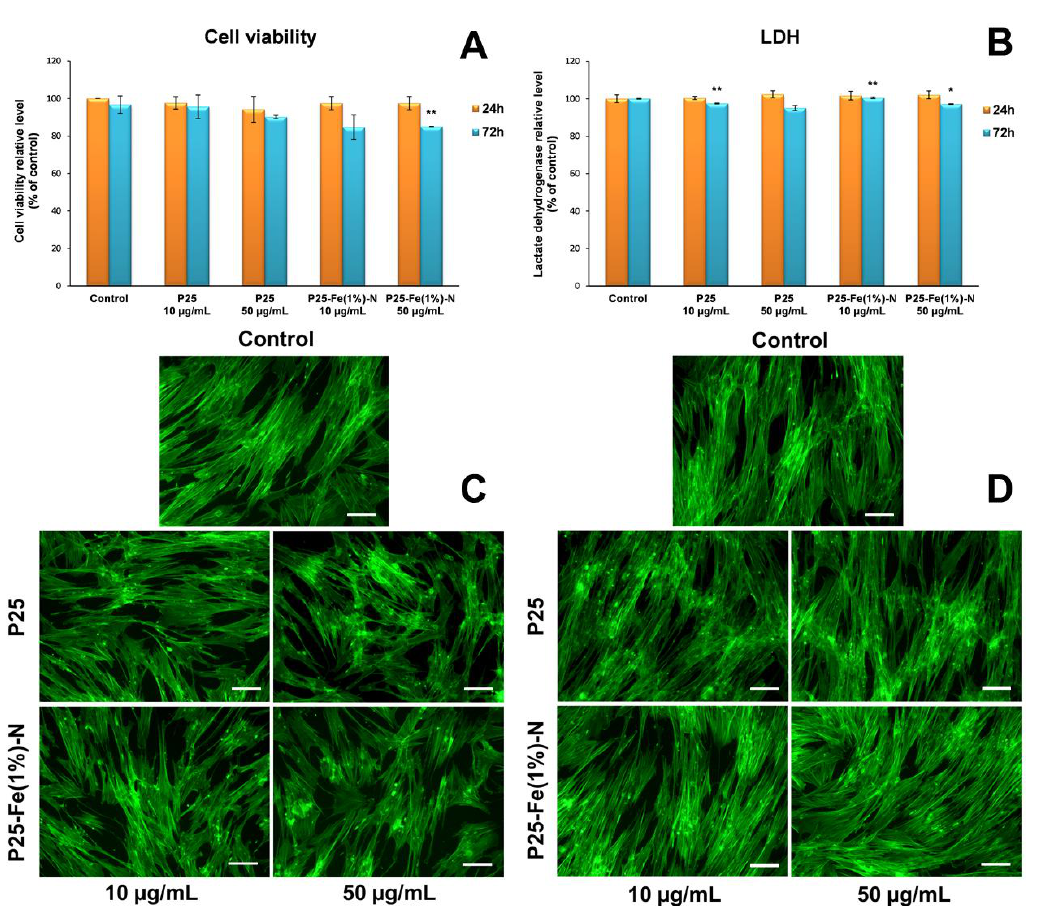
Figure 3. Biocompatibility of different concentrations (10 and 50 μg/mL) of the two TiO 2 NPs samples: P25 Degussa and P25-Fe(1%)-N, as shown by cell viability ( A ) and LDH release ( B ) after 24 and 72 h of exposure on normal lung fibroblasts. Results are expressed as means ± standard deviation (SD) ( n = 3) and represented relative to the untreated cells (control). * p < 0.05 and ** p < 0.01 compared to control. Actin cytoskeleton organization of lung fibroblasts after 24 ( C ) and 72 h ( D ) of incubation with different concentrations (10 and 50 μg/mL) of the two TiO 2 NPs samples: P25 Degussa and P25-Fe(1%)-N. F-actin (green) was labeled with phalloidin-fluorescein isothiocyanate (FITC). Scale bar: 100 μm.